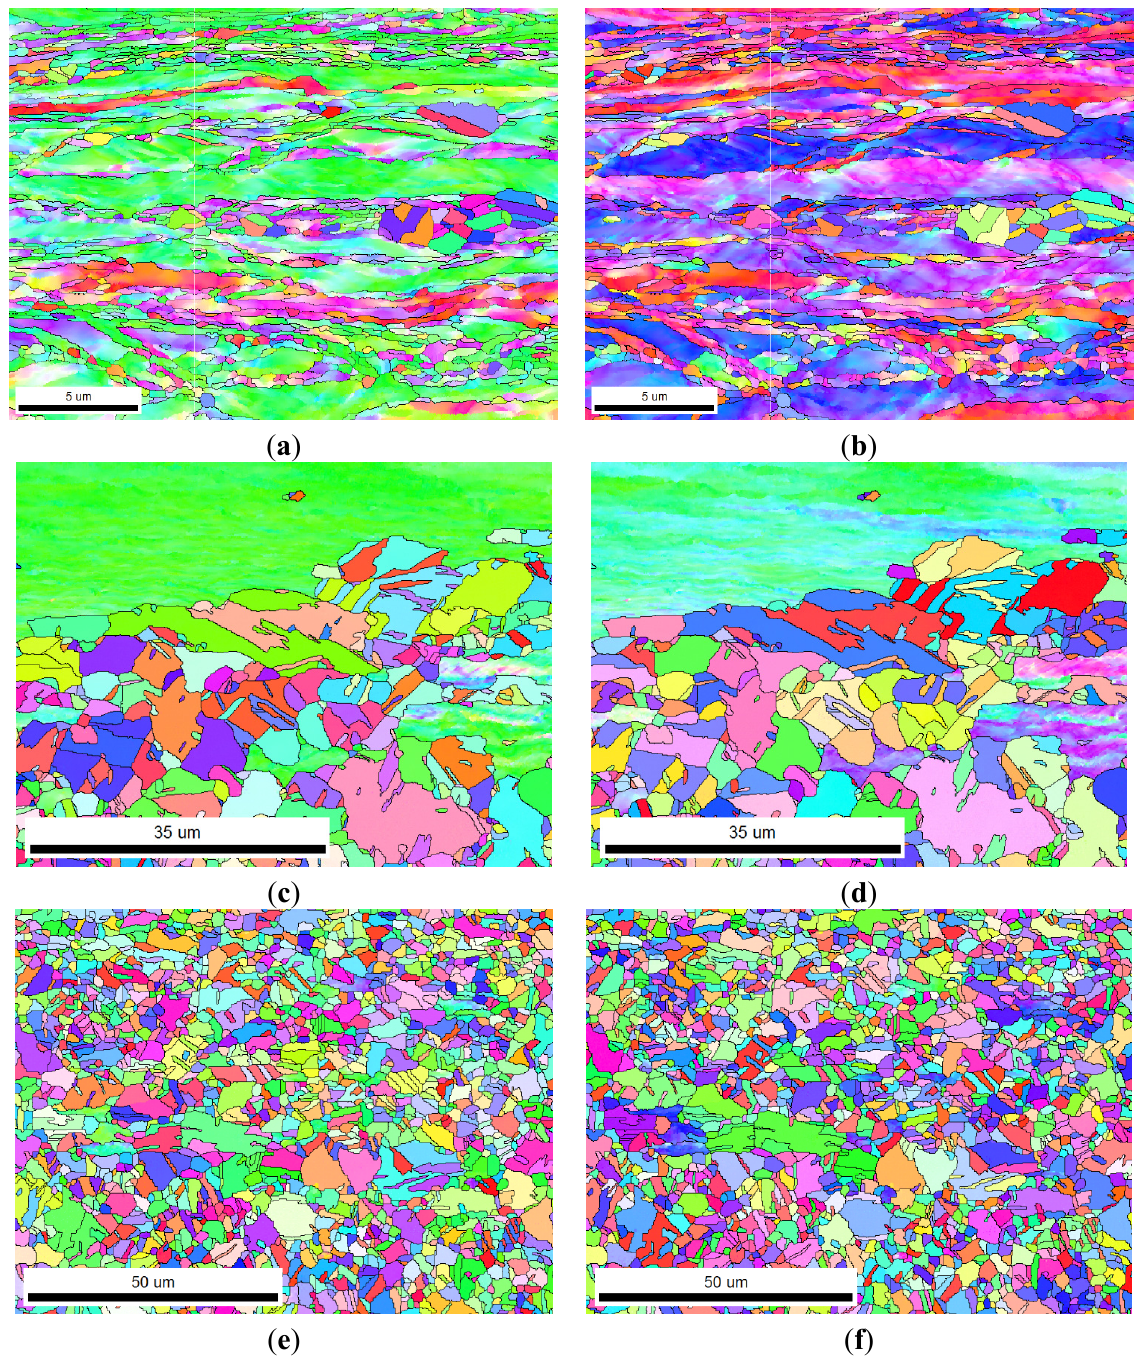
Figure 5. IPF maps of 90% cold-rolled FePd alloy after 700 °C annealing for ( a , b ) 10 s; ( c , d ) 20 s; and ( e , f ) 60 s. The corresponding color coding of the IPF is in terms of ND for ( a , c , e ) and RD for ( b , d , f